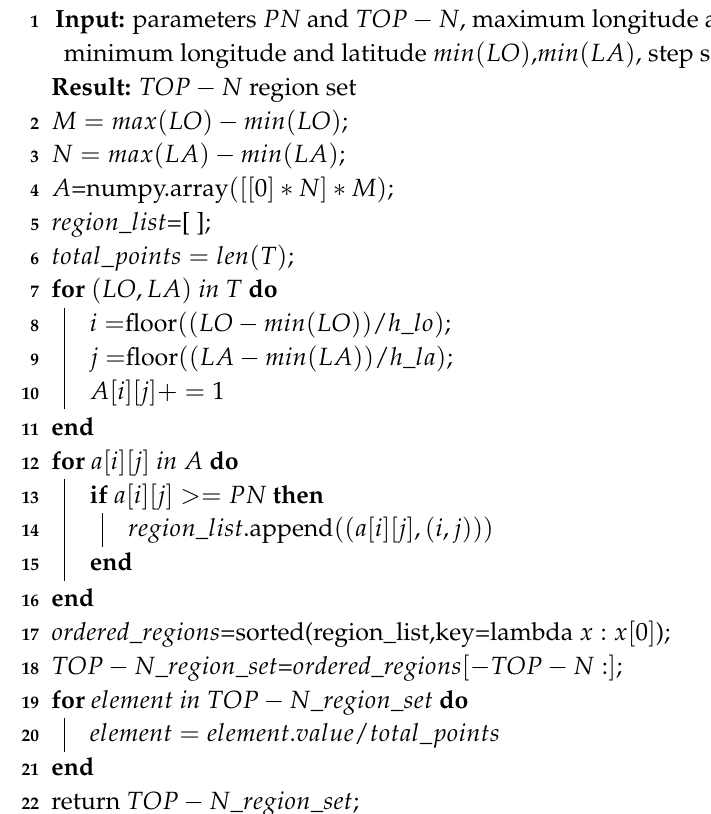
Algorithm 1: Get TOP − N region sequence from trajectory T